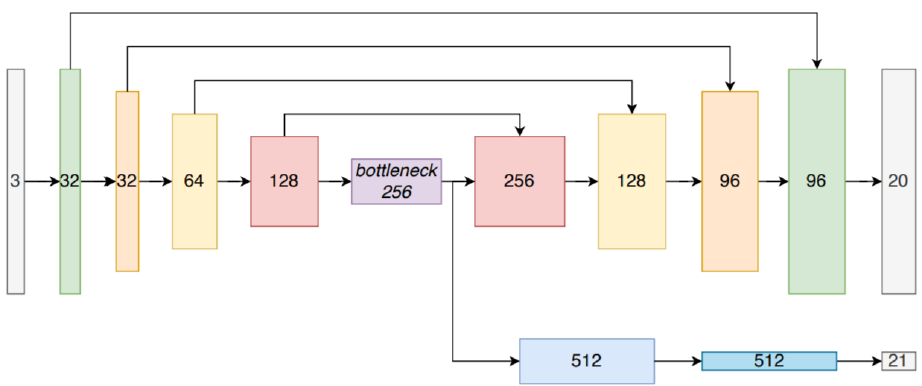
Figure 28. The multi-task network structure [81] for scene recognition in indoor